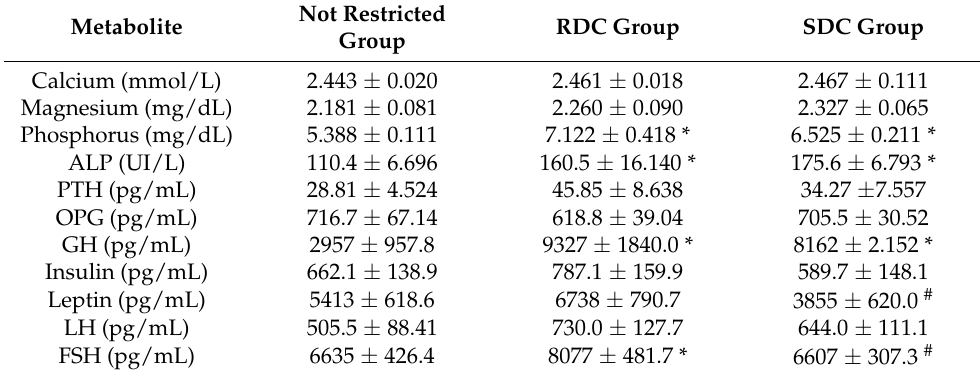
Table 3. Bone health-related hormones and serum